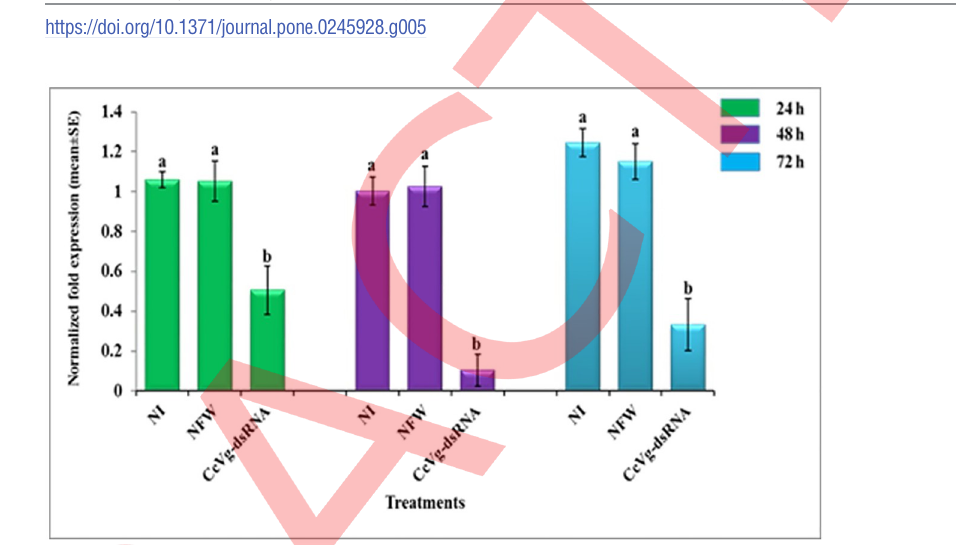
Fig 5. Expression profile of CcVg in Cadra cautella females. The 980 bp and 763 bp on right side are amplified products of CcVg and actin genes, respectively. M = molecular marker, bp = base pair, d = day.